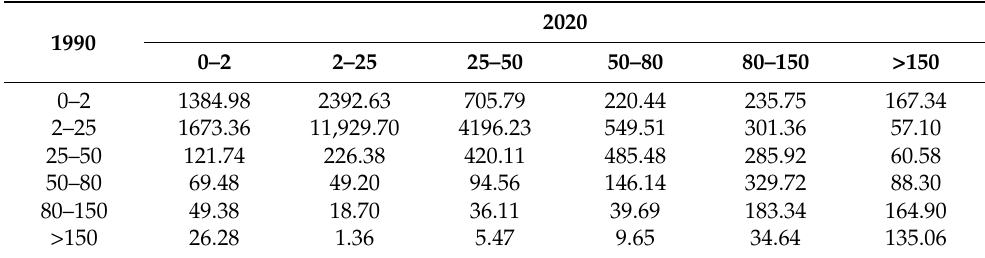
Table 2. Soil water erosion intensity transfer matrix in Baotou